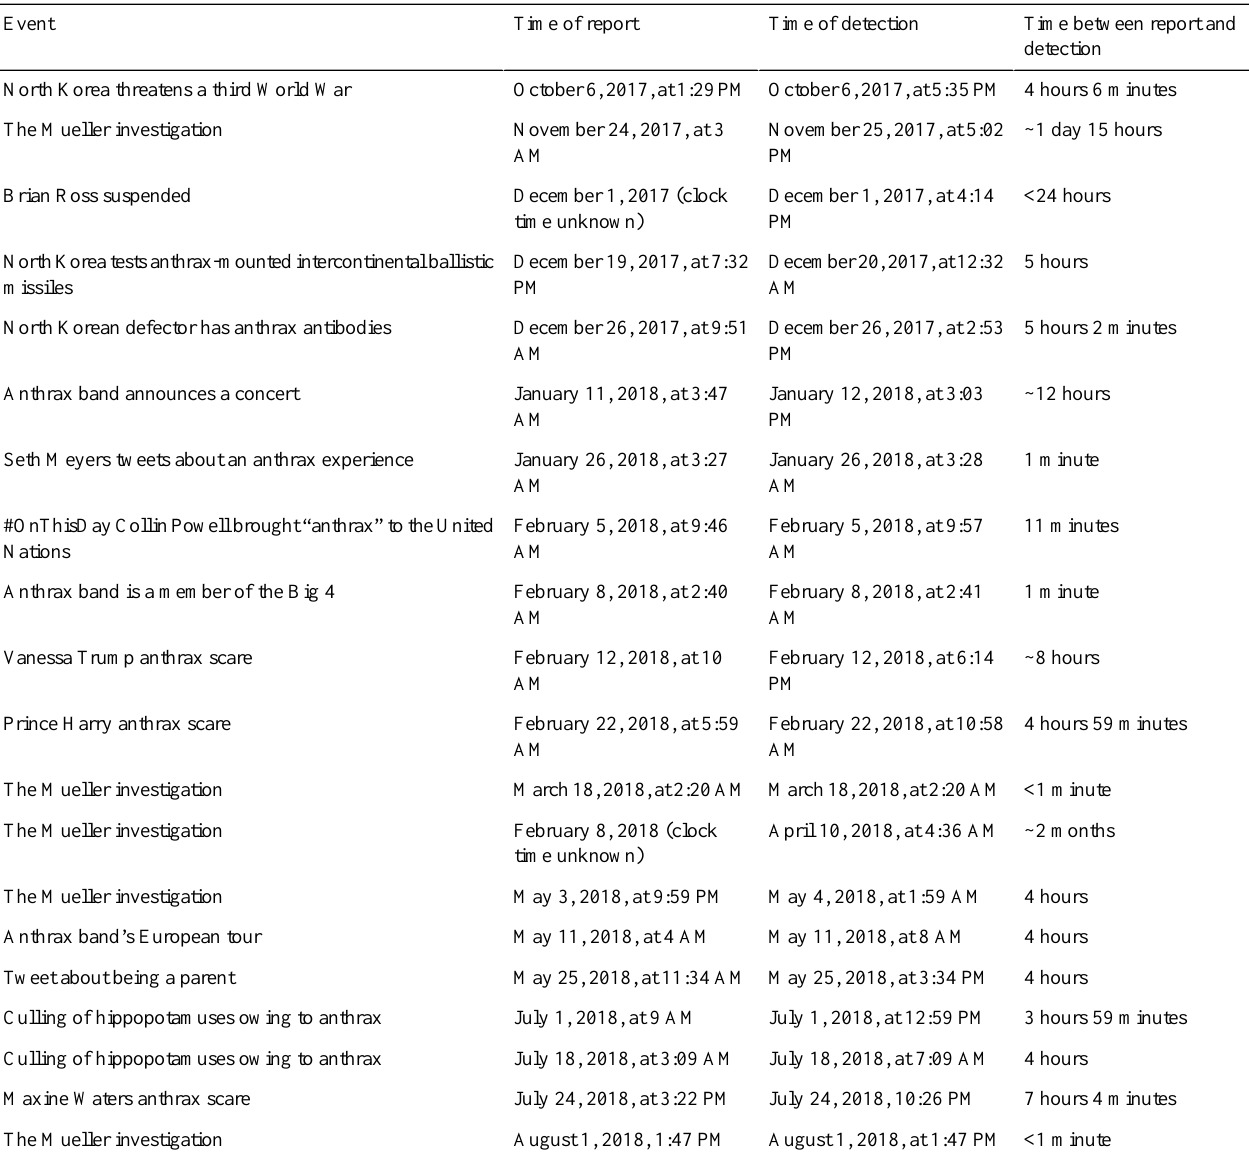
Table 1. Time of the news report or the first tweet concerning a detected discussion, time of the first tweet discussing the news article or the first retweet, and the time between the event and its